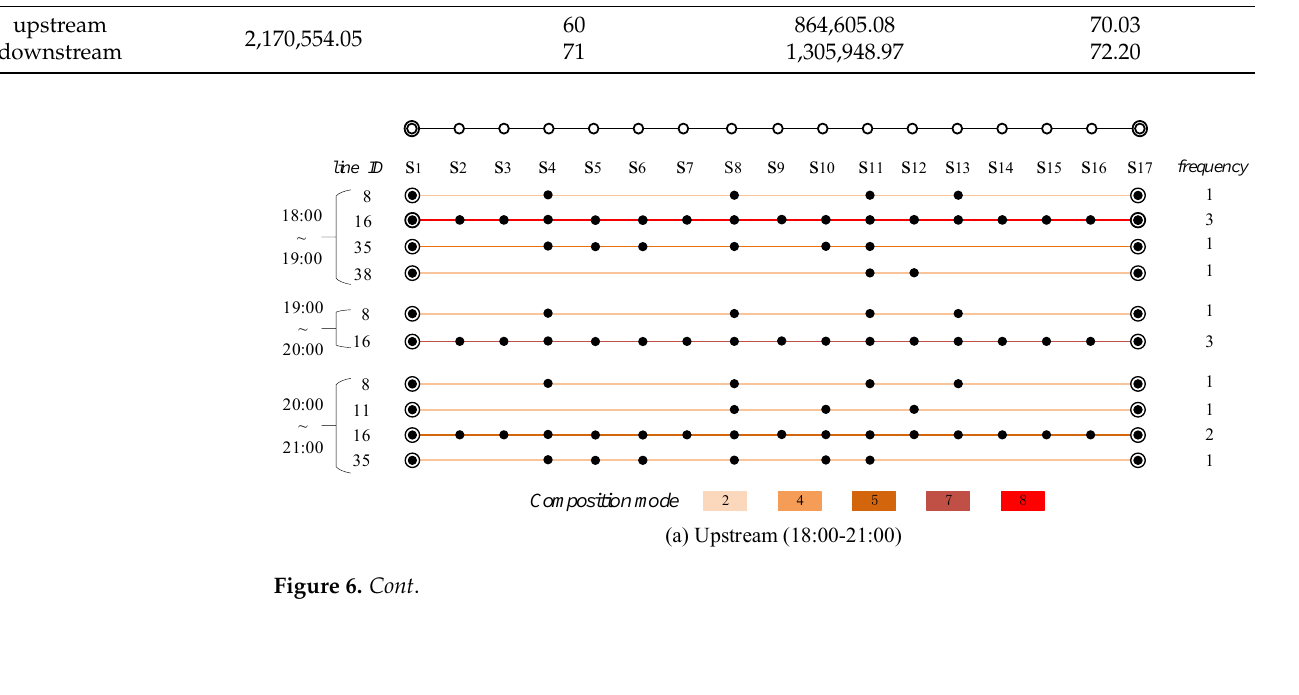
(b) Downstream (7:00-10:00) Figure 6. The line planning scheme in the up and downstream direction during the peak hours. Then, we analyze the transfer of carriage resources. Figure 7 shows the number of remaining carriages in the upstream and downstream directions at each time period. It can be clearly seen from Figure 7 that the changing trend of the number of remaining carriages in the upward direction and the downward direction is opposite. We can find that the maximum slopes of the two curves do not appear at the same time period because the carriages can be reused only after coupling, decoupling, and cleaning. With the help of the remaining carriage curves, we can determine when to replenish the carriages to guarantee the carriages can be dispatched.